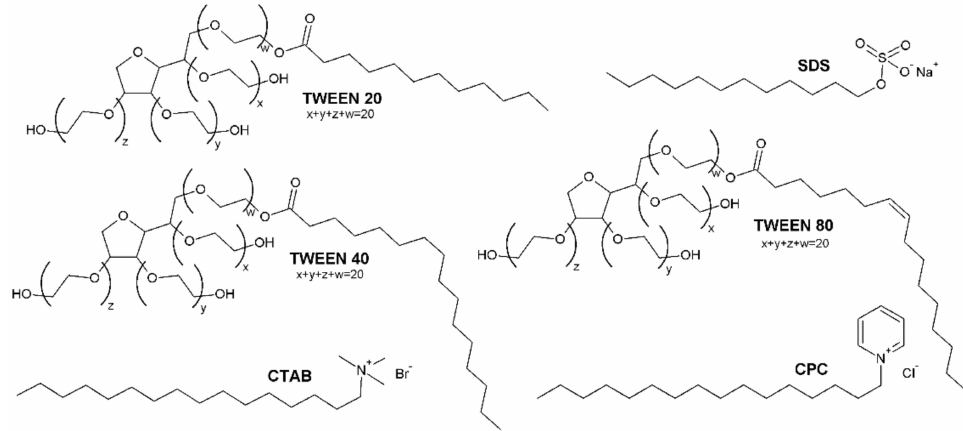
Figure 1. Molecular structures of the studied